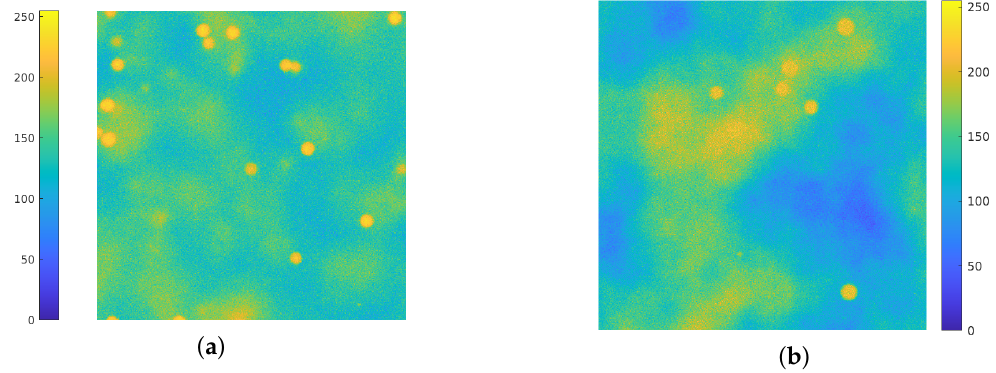
Figure 1. ( a ): an actual fluorescence microscopy image, of dimension 512 × 512. ( b ): a synthetic image, where the background fluorescence is simulated via Perlin noise. Both images are displayed with values in [ 0,255 ]